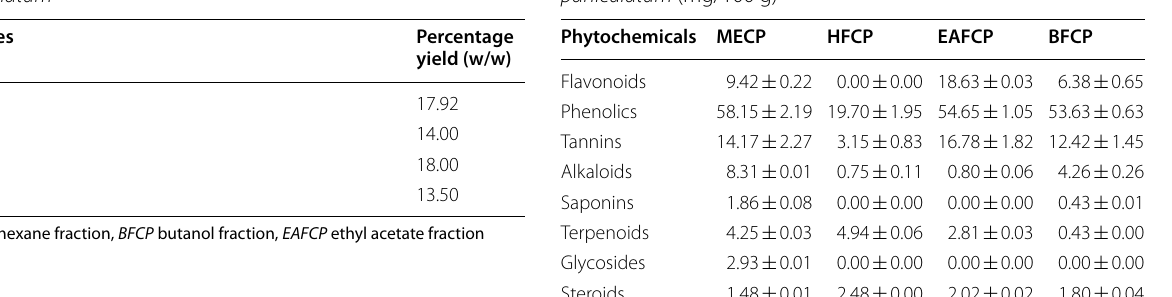
Table 3 Quantitative analysis of extract and fractions of C.